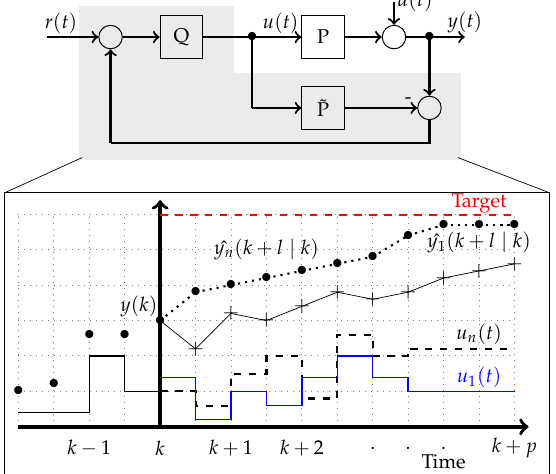
Figure 7. Working principle of MPC based on the “moving horizon” approach